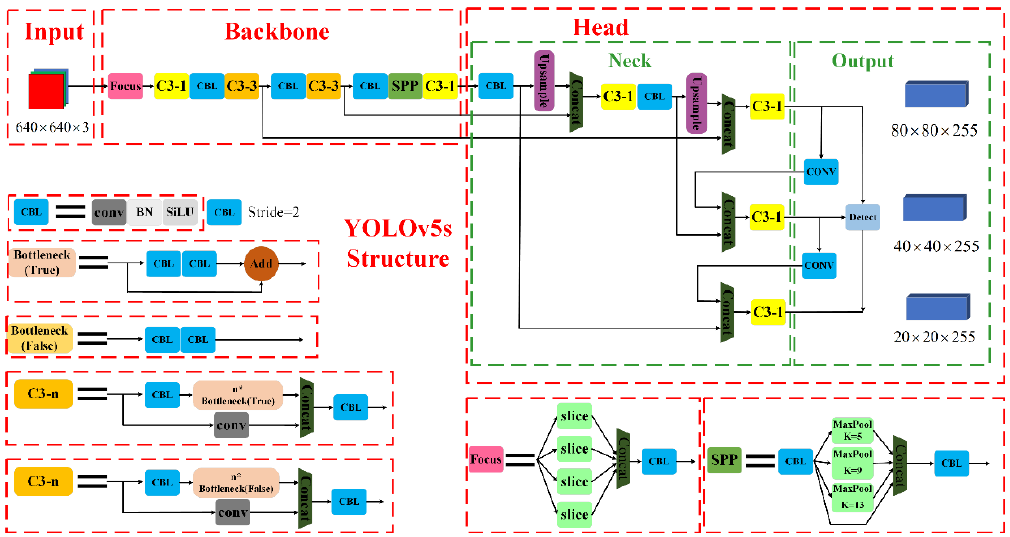
Figure 4. Network structure diagram of YOLOv5s.